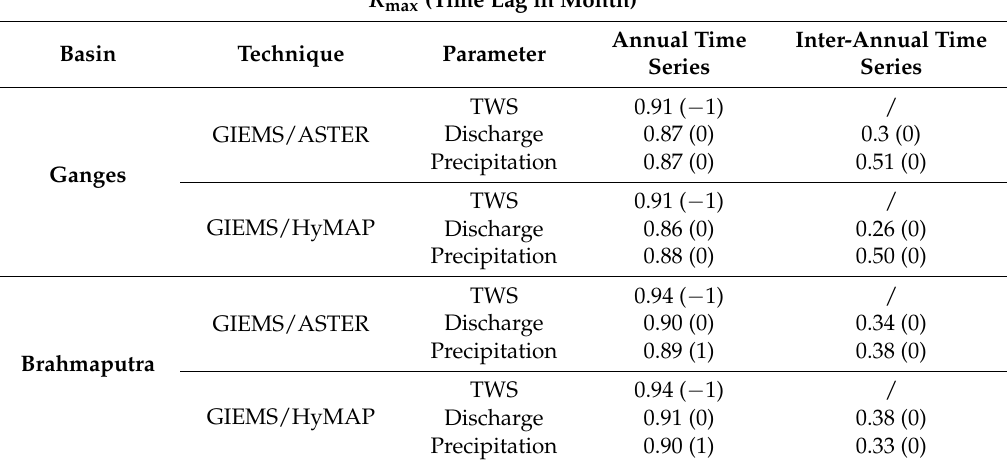
Table 2. Maximum cross correlation ( R max ) coefficients and time lags calculated between SWS time series (GIEMS/ASTER and GIEMS/HyMAP) and the three related hydrological parameters: TWS, discharge and